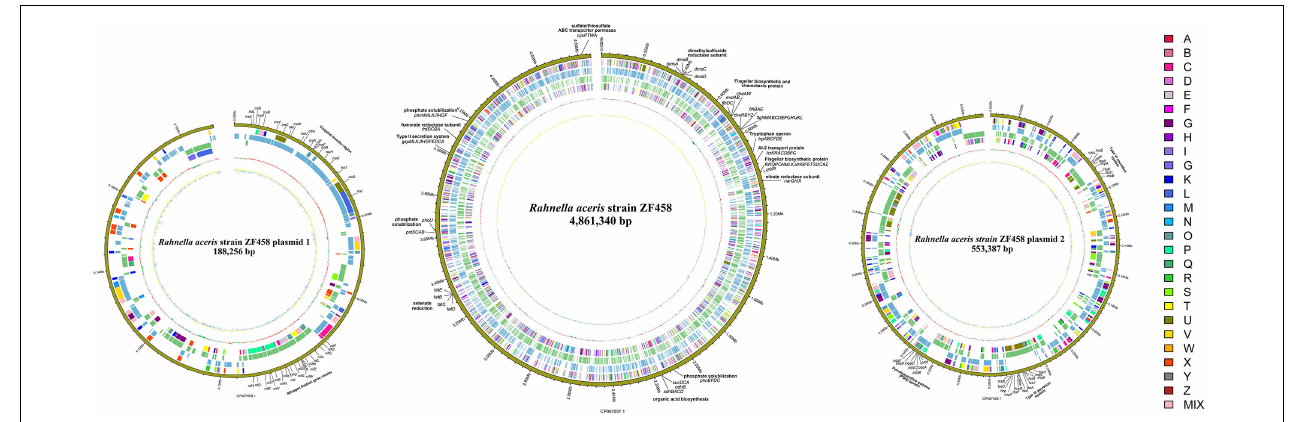
FIGURE 2 | Graphical circular maps of the R. aceris ZF458 chromosome and plasmids pPlas1 and pPlas2 genome generated using the CGview server. From outside to center, ring 1 showed the genome sequence position, rings 2 and 5 showed protein-coding genes oriented in the forward (colored by COG categories) and reverse (colored by COG categories) directions, respectively. Rings 3 and 4 showed coding genes in the forward (blue) and reverse (green) directions, respectively. Ring 6 showed the G + C% content and the inner most ring showed the GC skews, where blue indicated positive values and yellow indicated negative values.